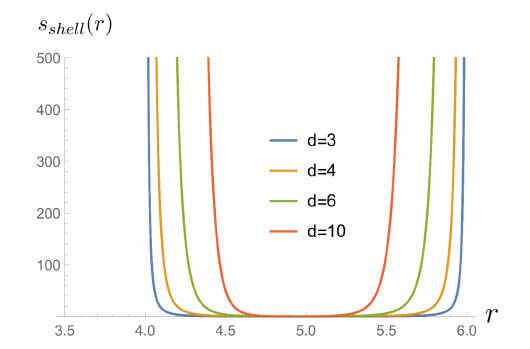
( r ) for spherical shell